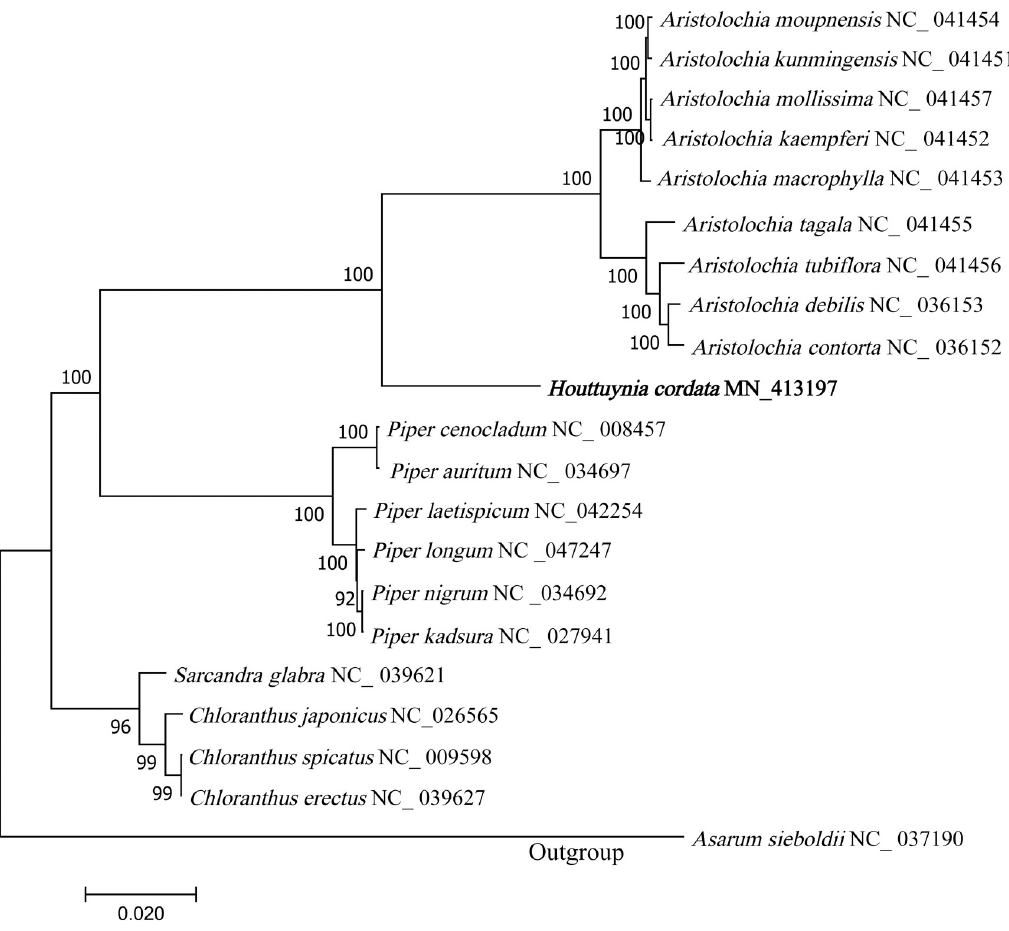
Fig 4. Phylogenetic relationship analysis of 21 Piperales species based on the shared common protein-coding sequence. The evolutionary history was inferred using the Maximum Likelihood method based on the Tamura-Nei model. The bootstrap values are shown next to the branches. The initial tree(s) for the heuristic search were obtained automatically by applying the Neighbor-Join and BioNJ algorithms to a matrix of pairwise distances estimated by the Maximum Composite Likelihood (MCL) approach, and then selecting the topology with the highest log value. The tree is drawn to scale, with branch length measured by the number of substitutions per site.